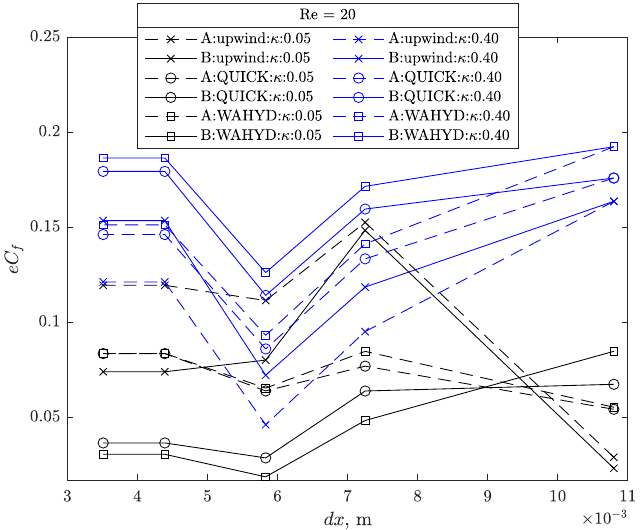
Figure 27. Drag coefficient error as function of grid size for the flow around a cylinder case with Re =